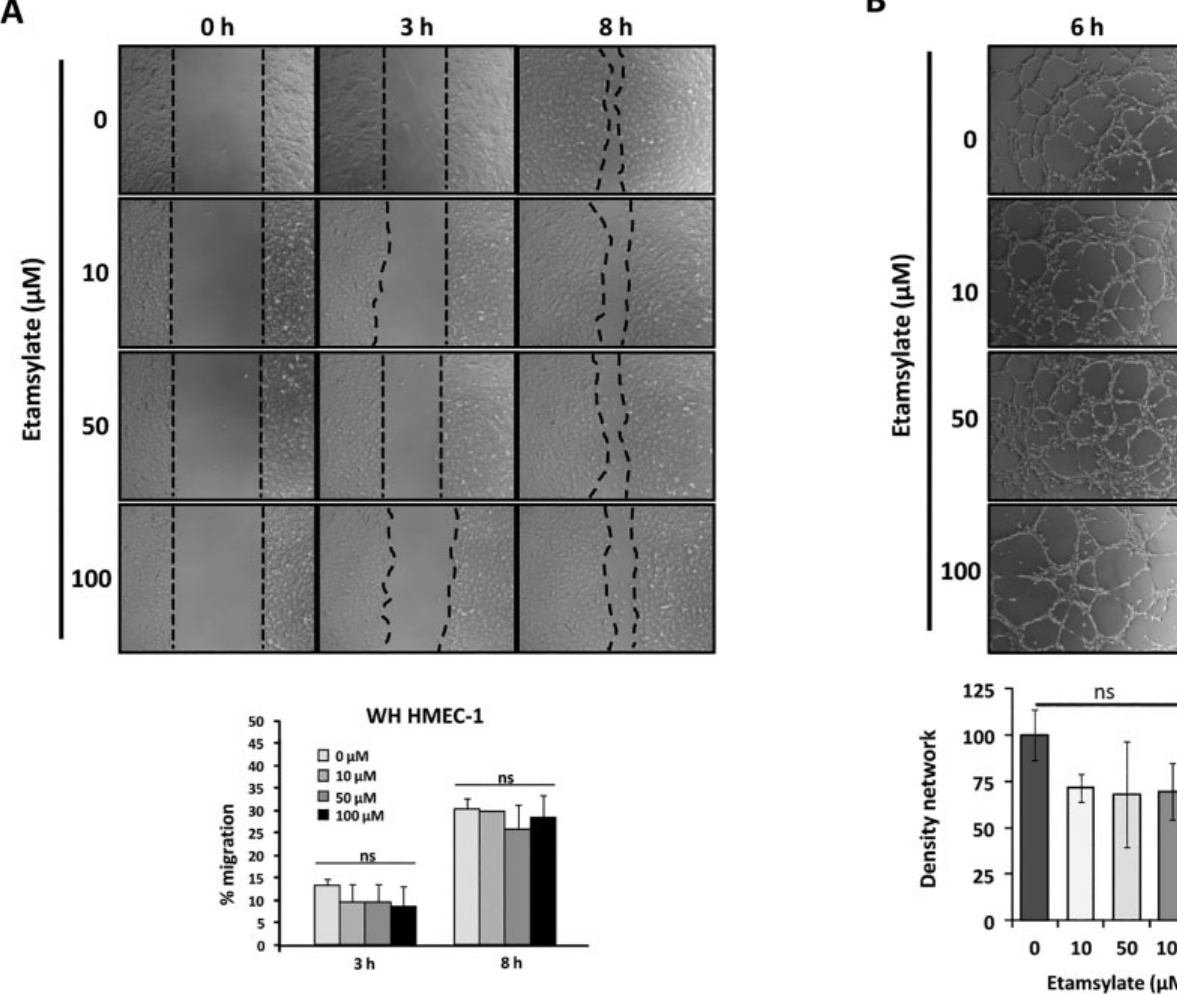
Fig. 1 Effect of etamsylate on angiogenesis in HMEC-1 cells. ( A ) Wound healing assay. In the upper part, representative images of the different experiments and replicas are shown. In the lower part, the percentage of migration in time is shown at different doses. ( B ) Tubulogenesis assay. In the upper part, representative images are shown. In the lower part, the tube densitiesper fi eldat different doses compared with the untreated cells are shown. Mean with the standard deviation is represented normalized versus control. Statistical signi fi cance was studied using Student ’ s t -test. No signi fi cant differences were found in this case